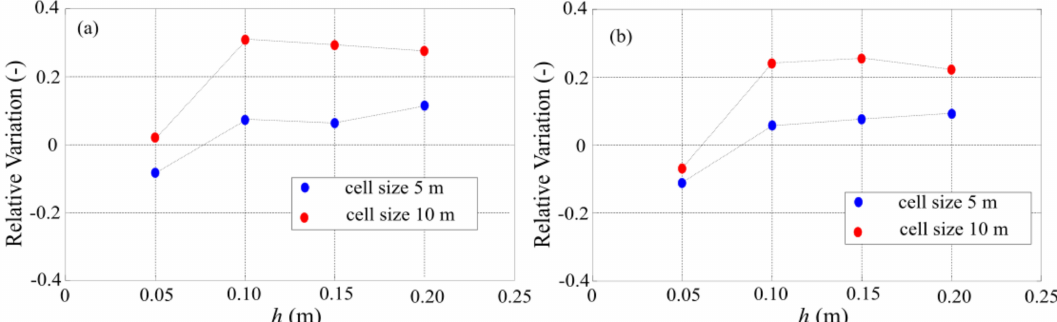
Figure 5. Flooded areas computed by HEC-RAS and SWE-FVM for pre-fixed water depth thresholds considering: T = 30 years, grid size 5 m ( a ) and 10 m ( b ), and T = 200 years, grid size 5 m ( c ) and 10 m ( d ).